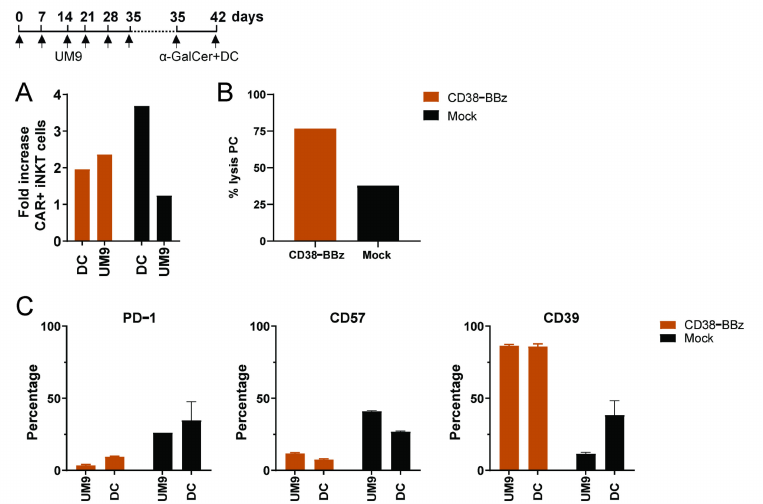
Figure 7. α -GalCer loaded DC induced expansion and activation of functional CD38-BBz CAR iNKT cells. Depicted is the culture scheme (upper panel A ) and the proliferation at Day 42 (lower panel A ) of CD38-BBz CAR iNKTs stimulated with CD38 + UM9 cells until Day 35, followed by stimulation with α -GalCer loaded DCs. ( B ) Cytotoxic activity of CD38-CAR and mock-transduced iNKT cells towards primary MM cells at the end of the cultures. ( C ) The percentage of iNKT cells expressing activation/exhaustion markers PD-1, CD57, and CD39. Error bars depict standard error of the mean (SEM) ( n =